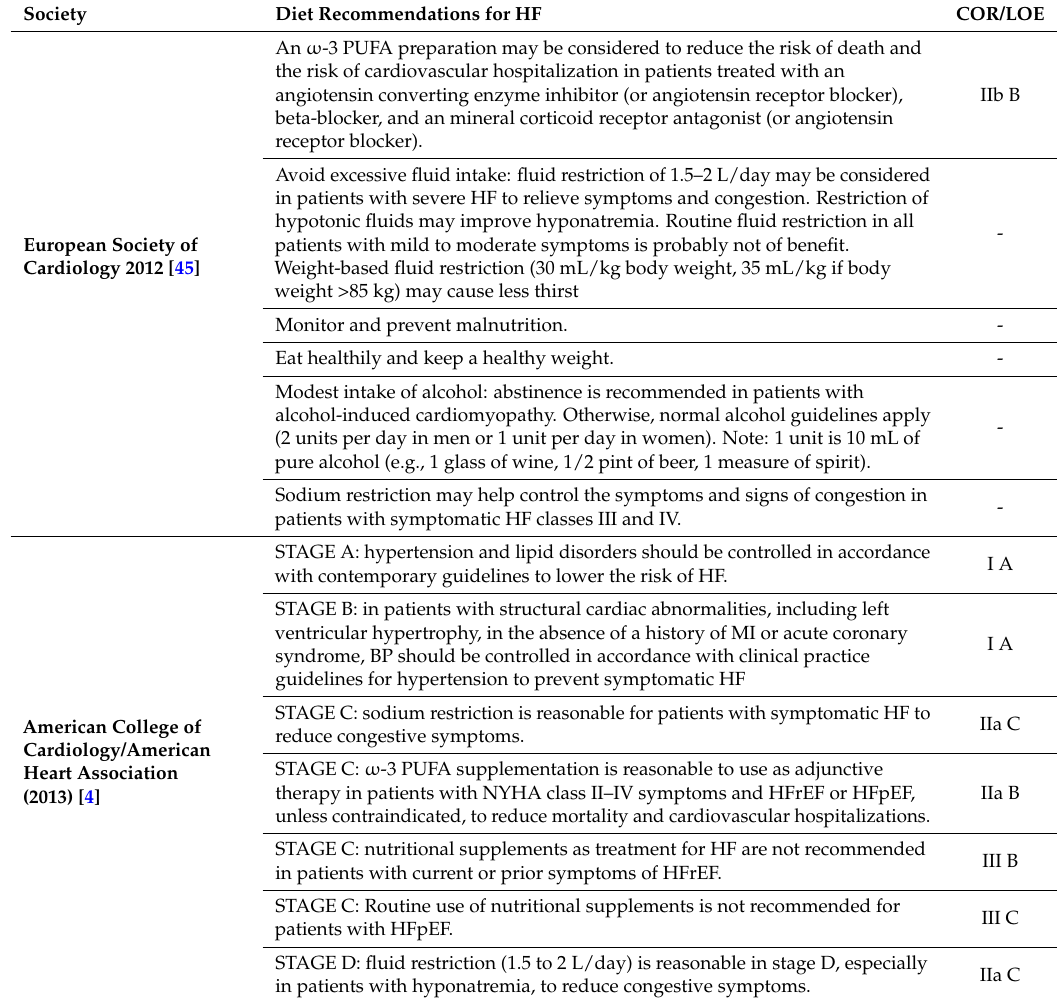
Table 5. ESC and ACC/AHA dietary recommendations for